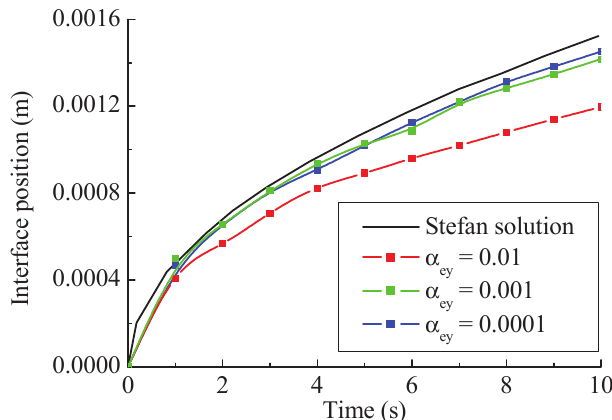
Appl. Sci. 2020 , 10 , x FOR PEER REVIEW Figure 5. Time histories of interface position by theoretical solution and current method.